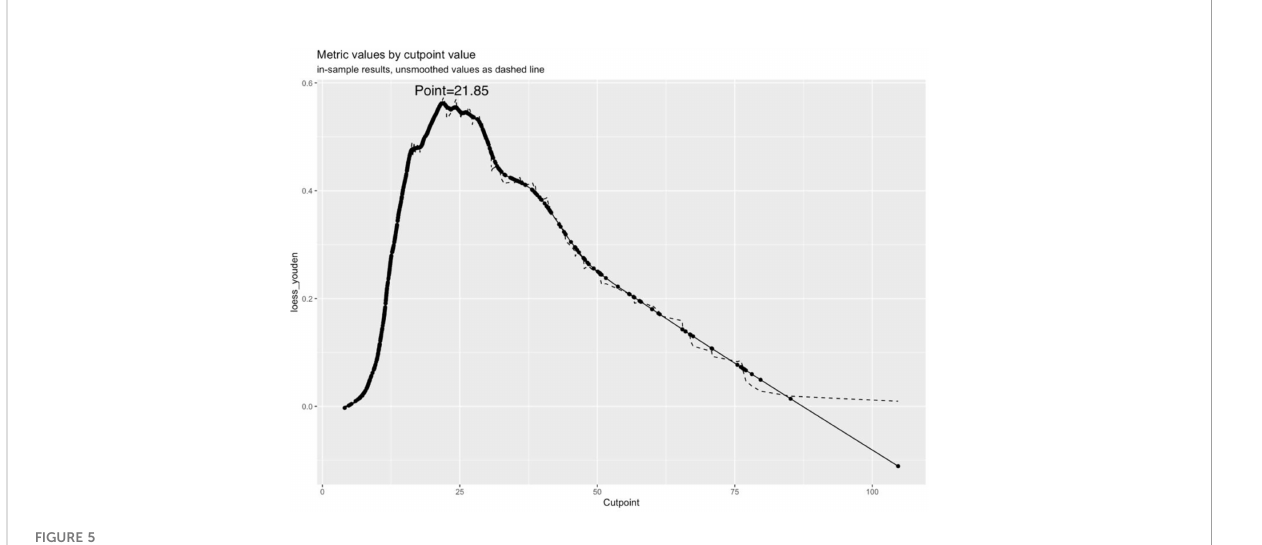
FIGURE 5 Youden curve and cut-off point.